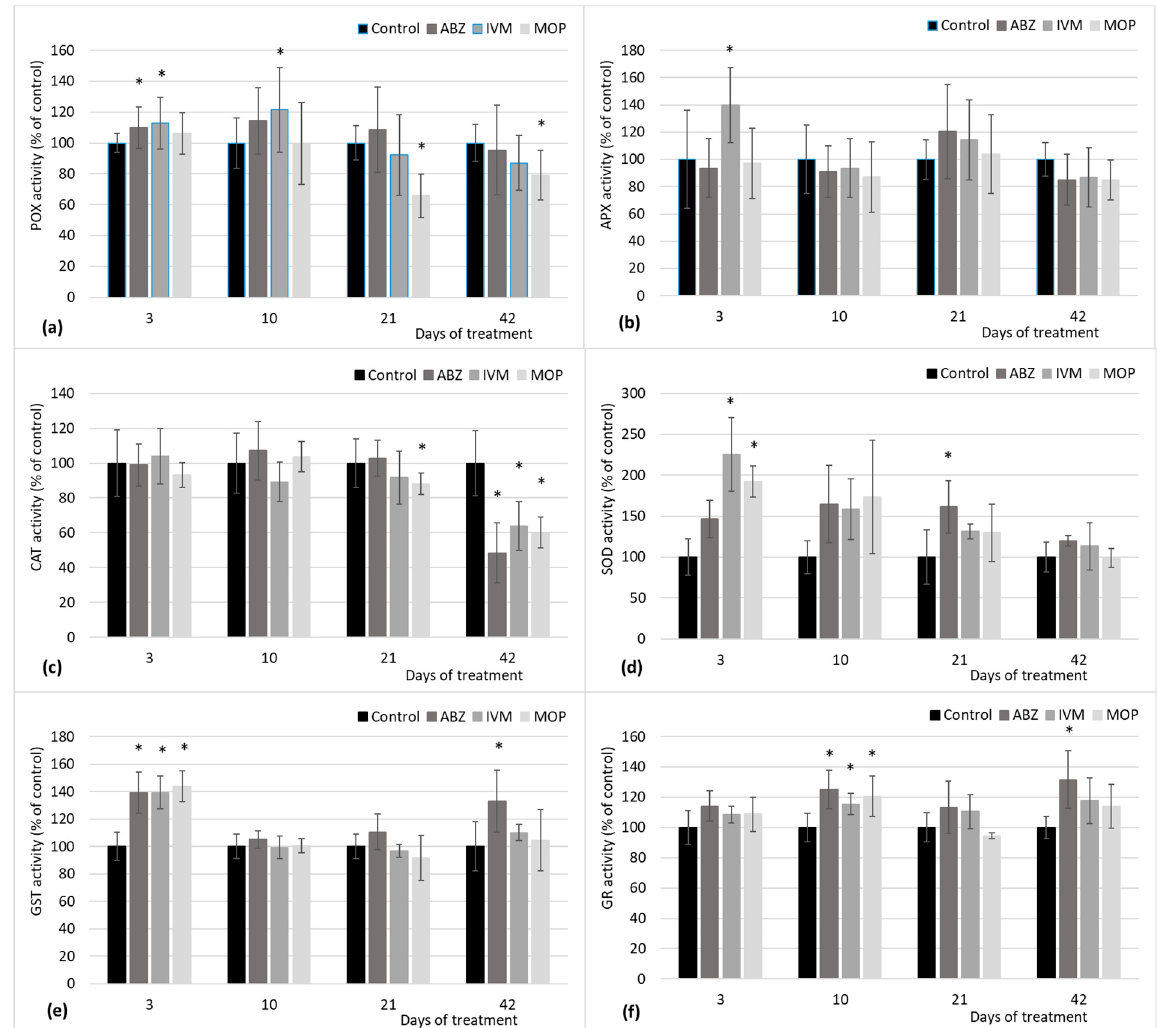
Figure 3. Changes in the activity of antioxidative enzymes: ( a )-guaiacol peroxidase (POX), ( b )-ascorbate peroxidase (APX), ( c )-catalase (CAT), ( d )-superoxide dismutase (SOD), ( e )-glutathione S-transferase (GST), and ( f )-glutathione reductase (GR) in T. pratense shoots fertilized with the manure of sheep treated with albendazole (ABZ), ivermectin (IVM) or monepantel (MOP). Time-dependence study. The data are expressed as mean ± SD, n = 3. Asterisks mark statistically significant differences comparing to control up to alpha ≤ 0.01. Table 1. Summarization of concentrations [ µ g · g − 1 faeces DW] of compounds in ovine